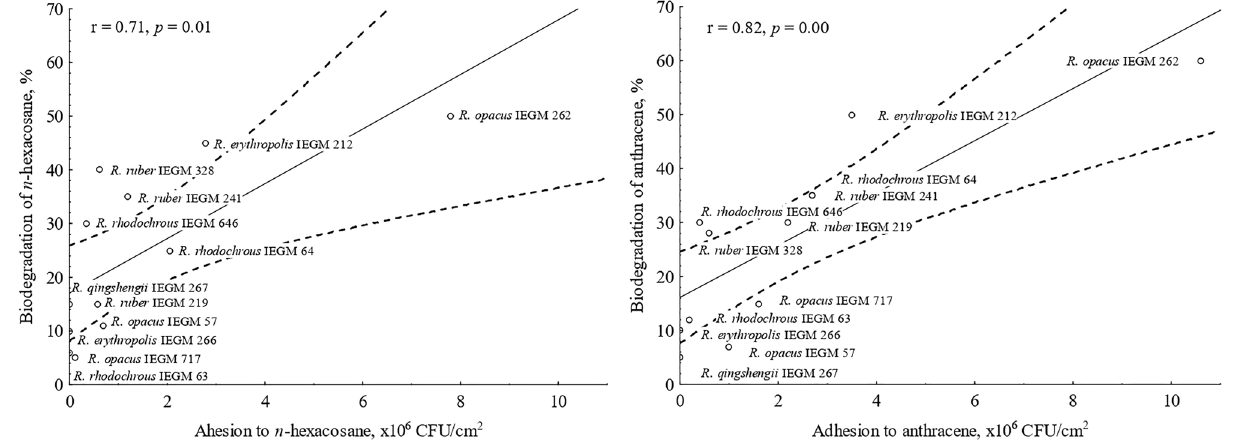
Figure 3. Correlations between the adhesive activities of Rhodococcus cells towards n- hexacosane and anthracene and biodegradation efficiency of these compounds at their concentration of 0.2% (w/w) after 9 days. Mean values, regression lines and 95% confidence limits are shown; r—Pearson’s correlation coefficient, statistically significant at p <